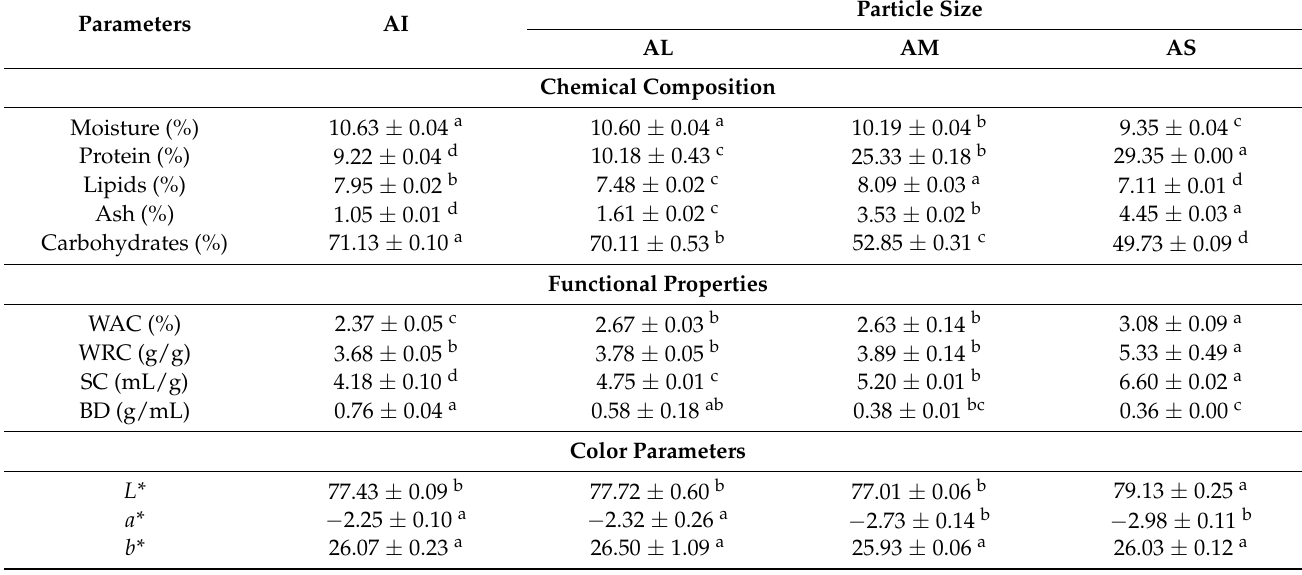
Table 1. Chemical composition, functional properties, and color parameters of large (AL), medium (AM), and small (AS) particle sizes compared with the integral amaranth